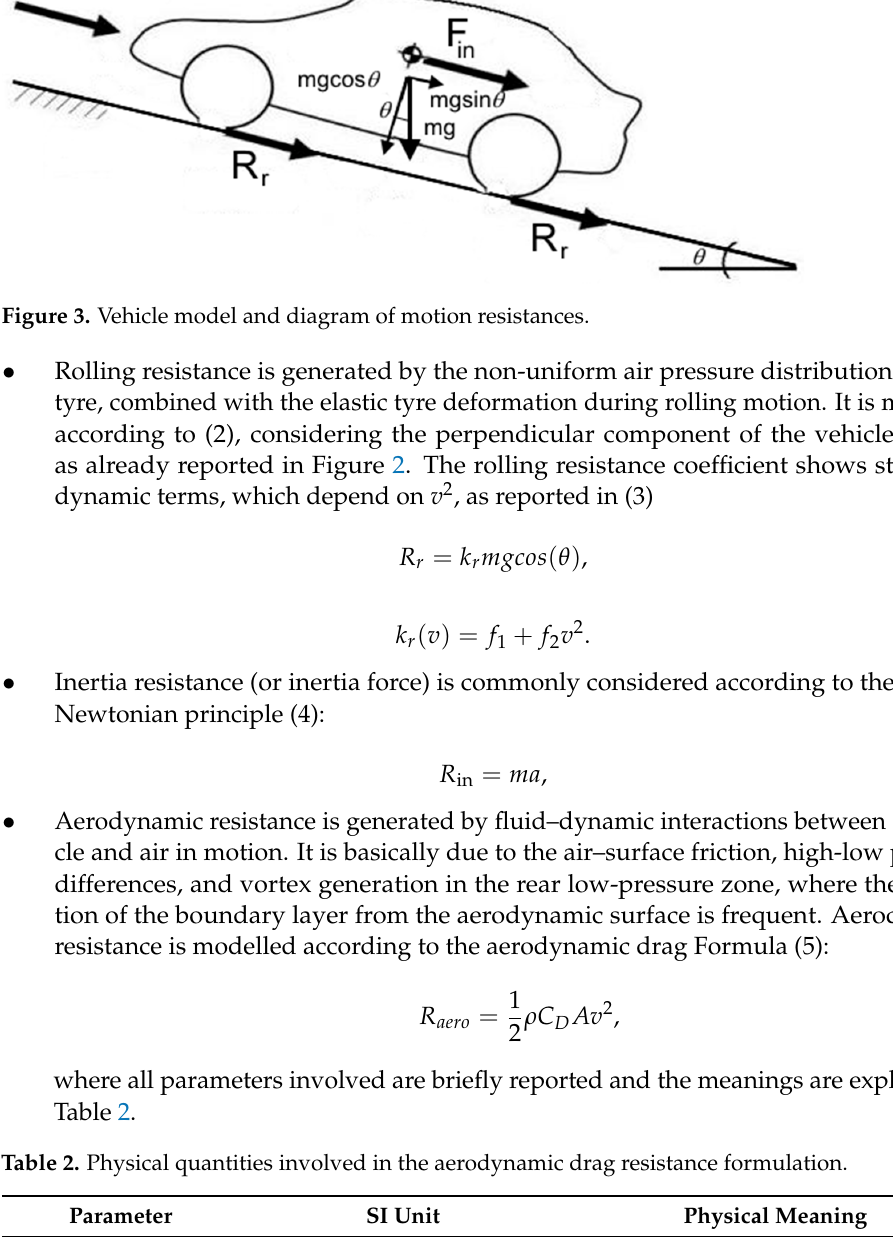
Table 2. Physical quantities involved in the aerodynamic drag resistance formulation.